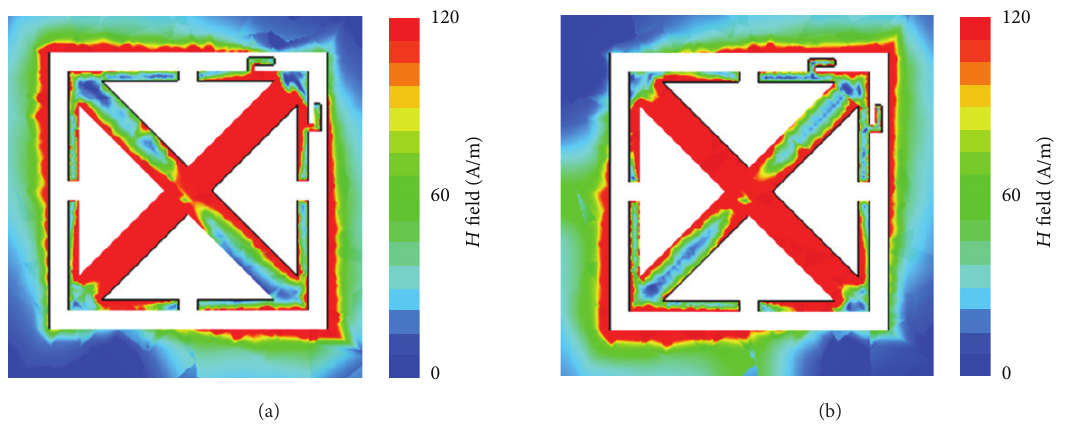
Figure 8: Simulated current distributions of the final filter: (a) 𝑓 1 = 5.77 GHz; (b) 𝑓 2 = 5.8 GHz.